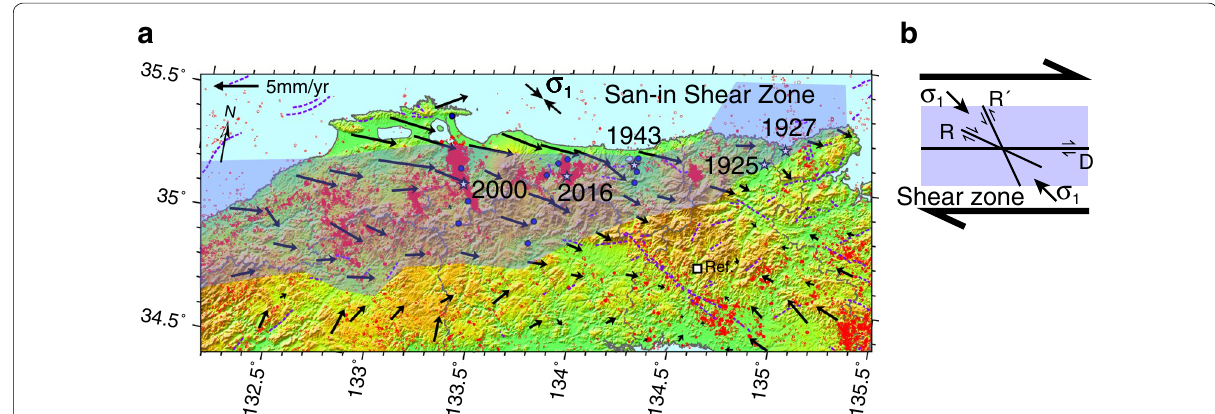
Fig. 3 a GNSS velocities, shallow seismicity, and active faults in and around the San-in shear zone (SSZ). Purple broken lines are active faults (Research Group for Active Faults in Japan 1991). Red dots are seismicity with magnitude of 1 and a depth of <30 km during 1998–2016. White ≥ stars are epicenters of shallow M 6.5 earthquakes with their occurrence year. Blue circles are new GNSS stations installed in 2014. A direction of ≥ maximum compressional stress in the SSZ (Kawanishi et al. 2009) is indicated by a couple of arrows . b Schematic Riedel shear in a shear zone. D , R , and R ′ are principal displacement shear, Riedel shear and conjugate Riedel shear,